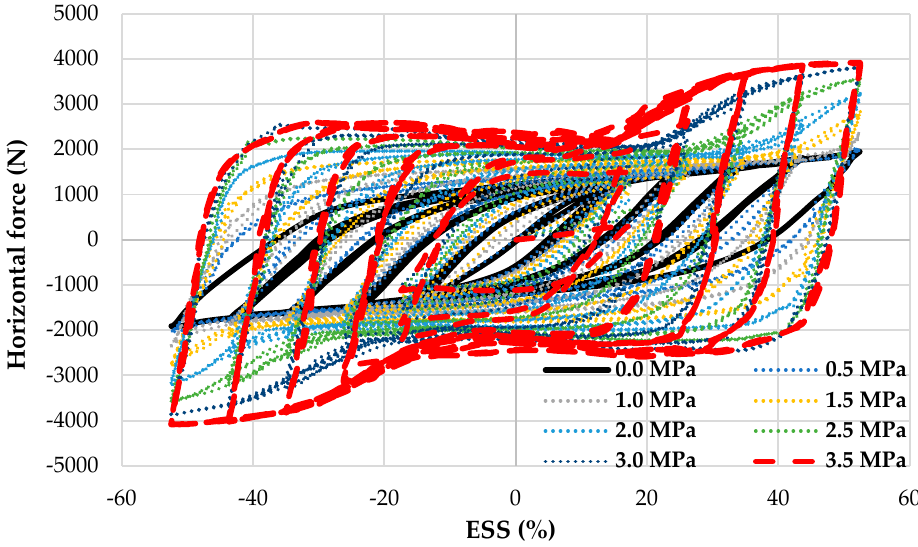
Figure 14. Illustrating force–displacement hysteresis curves of the proposed model for cyclic analyses without/with normal pressure variations.